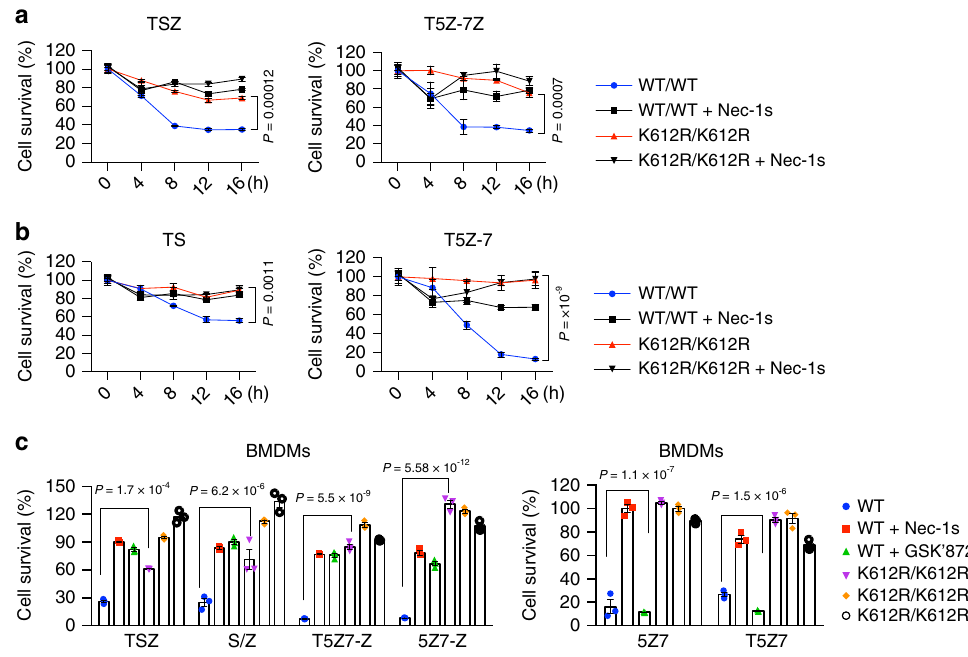
Fig. 1 RIPK1 K612R mutant cells are resistant to necroptosis induced by TNF α . a , b Ripk1 + / + and Ripk1 K612R/K612R immortalized MEFs were pretreated with SM-164 (100 nM) or 5Z-7 (5Z 7-oxozeanol) (200 nM) for 1.5 h in the presence or absence of Nec-1s (10 μ M) as indicated, and then treated with TNF α (100 ng/ml)/Z-VAD (25 μ M) ( a ) or TNF α (100 ng/ml) ( b ) for different time points. Cell survival was measured by Cell TiterGlo. Data are presented as mean ± SEM of n = 3 biologically independent samples. Two-way ANOVA with Bonferroni ’ s multiple comparison test. c WT and RIPK1-K612R primary BMDMs were pretreated with SM-164 (100 nM) or 5Z-7 (200 nM) for 1.5 h in the presence or absence of Nec-1s (10 μ M) or GSK ’ 872 (10 μ M) as indicated, and then treated with TNF α (100 ng/ml) alone or Z-VAD (25 μ M) alone or Z-VAD (25 μ M) plus TNF α (100 ng/ml) for 10 h. Cell survival was measured by Cell TiterGlo. Data are presented as mean ± SEM of n = 3 biologically independent samples. Two-way ANOVA with Bonferroni ’ s multiple comparison